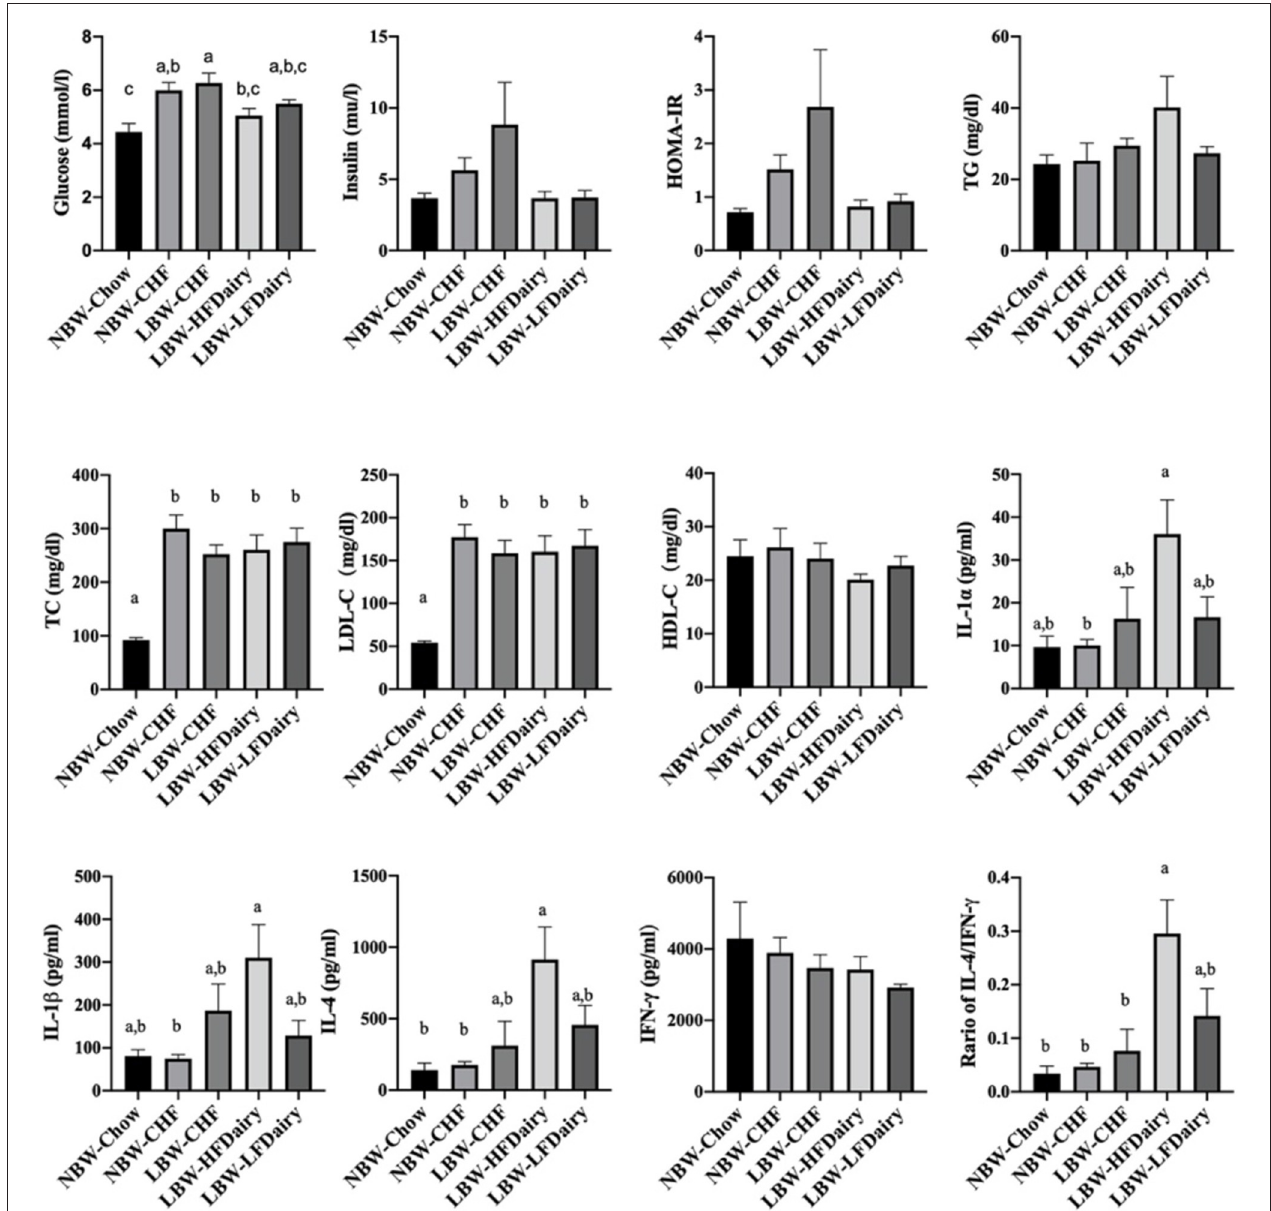
FIGURE 2 | Changes on fasting plasma biochemical parameters and inflammatory cytokines in LBW and NBW swine fed different experimental diets. P -model for insulin = 0.094; P -model for HOMA-IR = 0.08. CHF, control high-fat diet; HDL-C, high-density lipoprotein cholesterol; HFDairy, high-fat dairy diet; HOMA-IR, homeostatic model assessment for insulin resistance; IFN- γ , interferon-gamma; IL, interleukin; LBW, low birthweight; LDL-C, low-density lipoprotein cholesterol; LFDairy, low-fat dairy diet; NBW, normal birthweight; TC, total cholesterol; TG, triglycerides; TNF- α , tumor necrosis factor-alpha. All values are expressed as means ± SEM. A p -value was considered as statistically significant when < 0.05. Means sharing the same letter were not significantly different from each